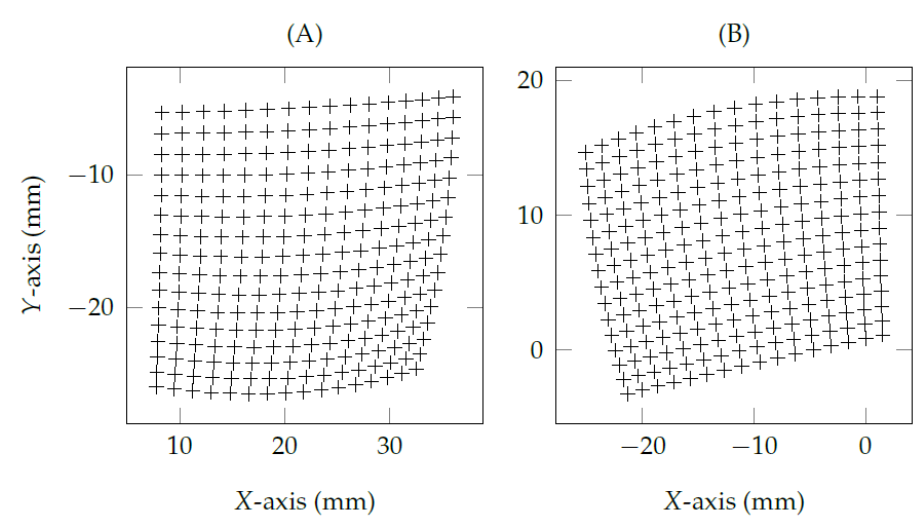
Figure 2. The eye-camera location changes the shape and coordinates of a nonlinear eye feature distribution. The crosses represent a set of 16 × 16 simulated pupil centers from a remote eye tracker. In these simulations, the eye-camera location (in millimeters) related to the world coordinate system (i.e., the bottom-center of the screen) were: ( A ) ( − 250,400,0 ) ; and ( B ) ( 250,0,0 ) .